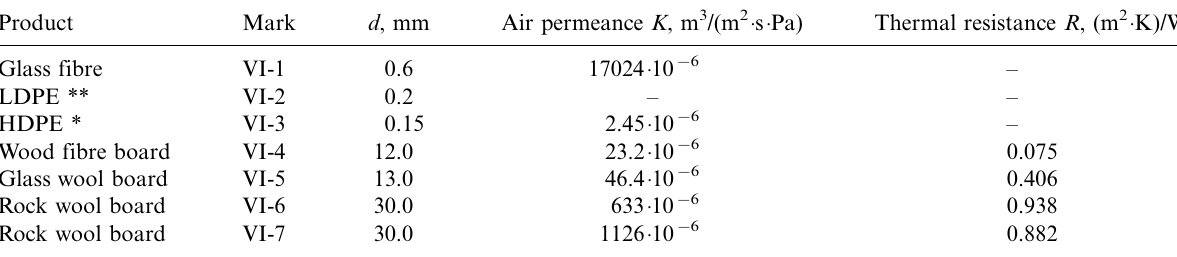
Table 3. Thermal-technical properties of wind protecting products Product